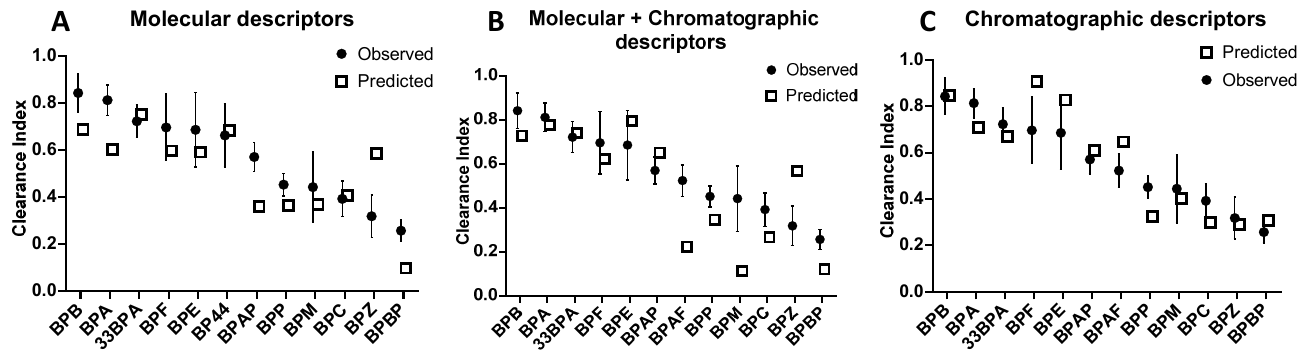
Figure 4. Mean ± SD observed CI determined for the BPs on five perfused human placentae compared to the CI predicted by QSAR models based on molecular descriptors ( A ), molecular combined with chromatographic descriptors ( B ), and chromatographic descriptors ( C ). The placental CI of